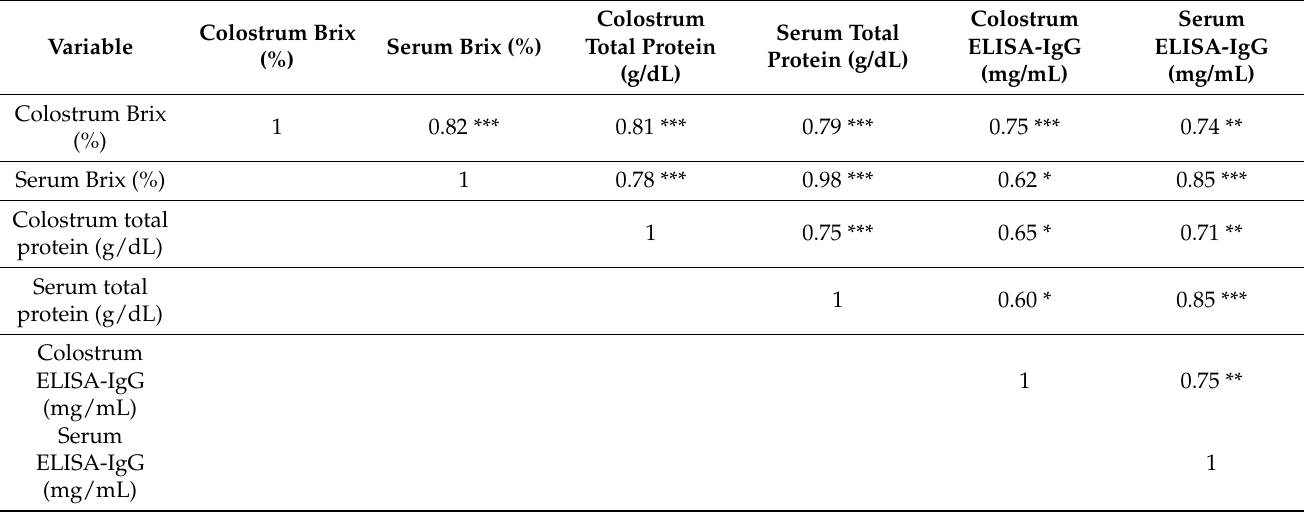
Table 4. Pearson correlation coefficients for selected variables.